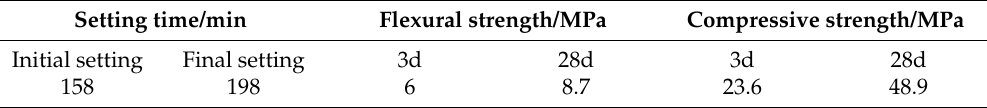
Table 1. Properties of ordinary Portland cement.